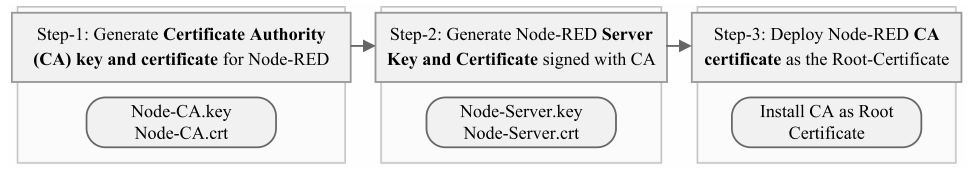
Figure 6. Securing steps for IIoT